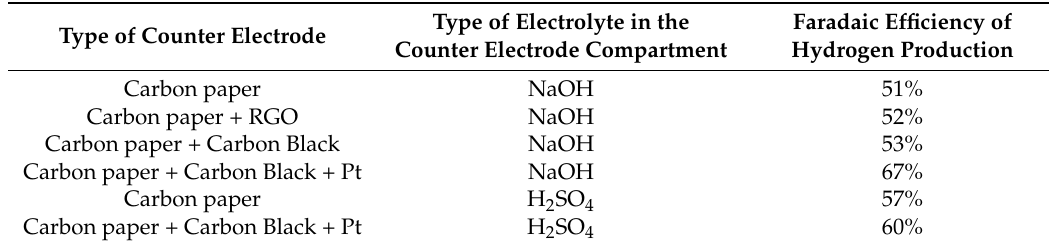
Table 1. Faradaic efficiency for photoelectrochemical hydrogen production by reduction reactions at the counter electrode at various pH values and with various counter